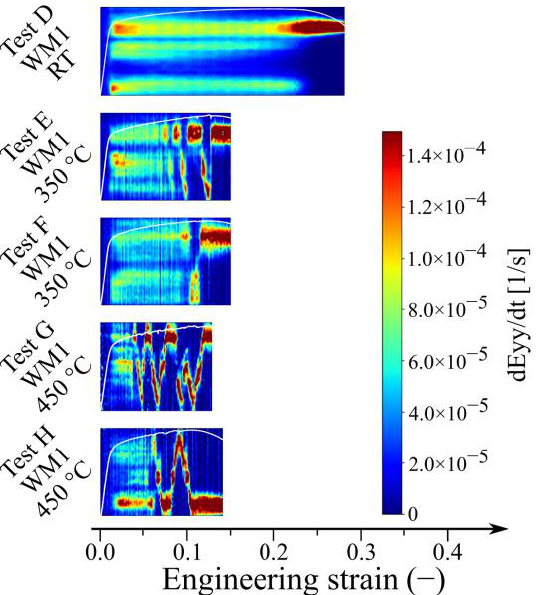
Figure 5. Strain rate maps of tests performed on the SAW material (WM1) at RT (Test D), at 350 °C (Test E and F) and at 450 °C (Test G and H). The engineering stress – strain curves of each test are overlaid on the strain rate maps in white.